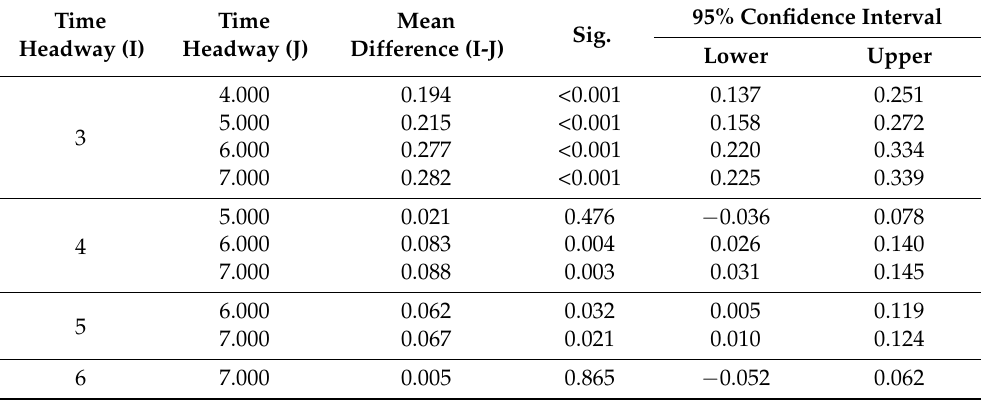
Table 7. Multiple comparisons of the effect of vehicle time headway on pedestrian crossing